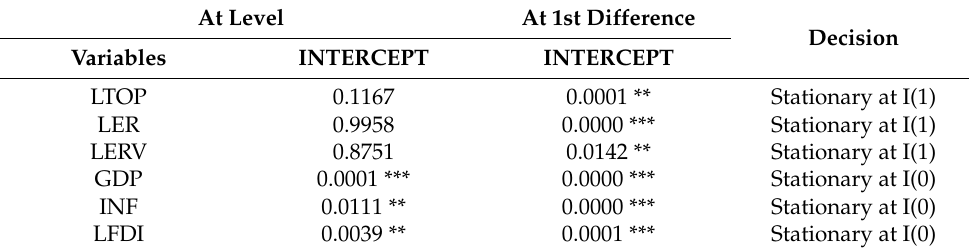
Table 2. Result of Stationarity test with the ADF test. At